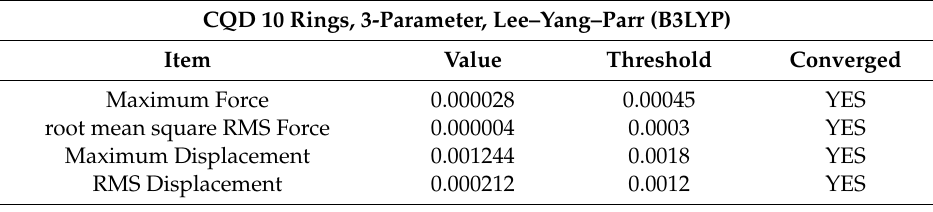
Table 3. Pertinent parameter for optimization of CQD molecular structure.